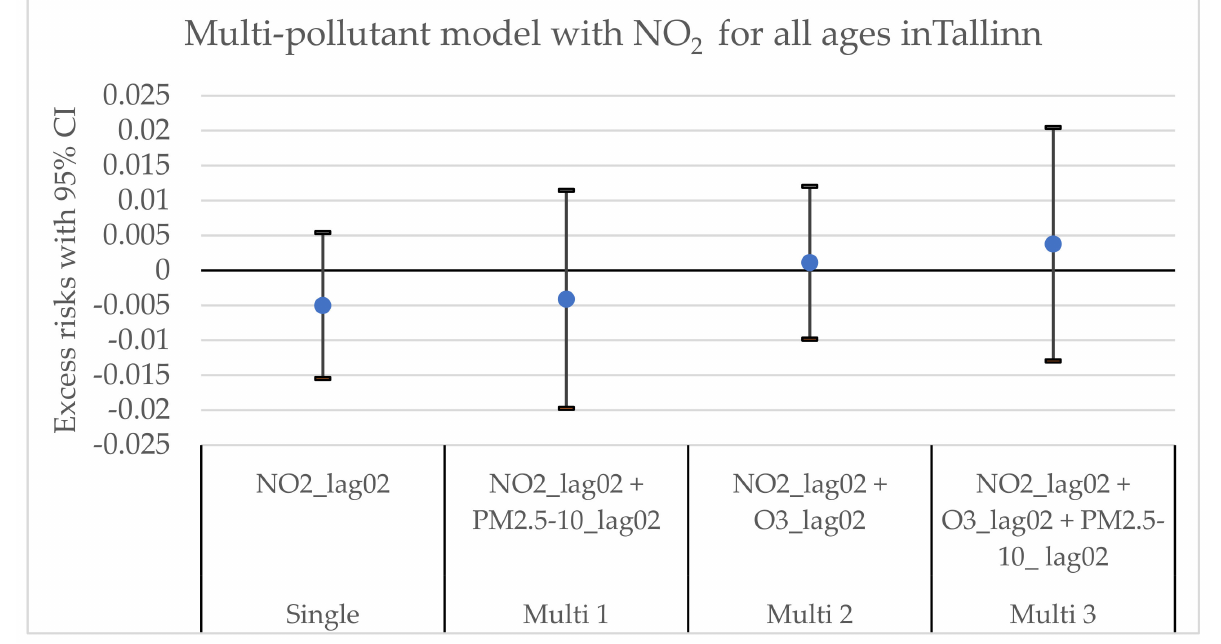
Figure A8. Multi-pollutant models of the estimated change in daily mortality in all ages (with 95% CI) for an IQR increase in the concentration of NO 2. (lag02) in Tallinn. From left to right: a single-pollutant estimate of NO 2 (Single), NO 2 adjusted for PM 2.5–10 (Multi 1), NO 2 adjusted for O 3 (Multi 2), and NO 2 adjusted for both O 3 and PM 2.5–10 (Multi